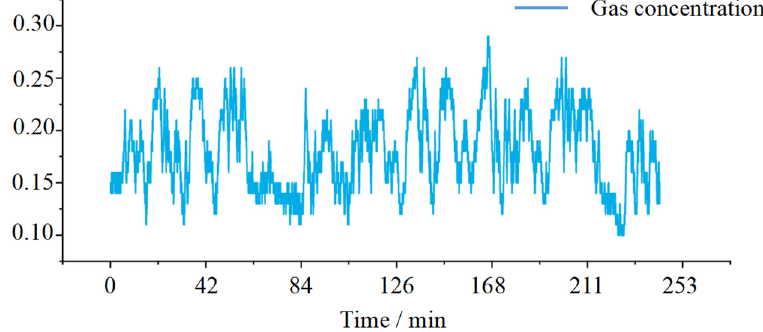
Figure 5. Original sequence diagram of gas data collection.